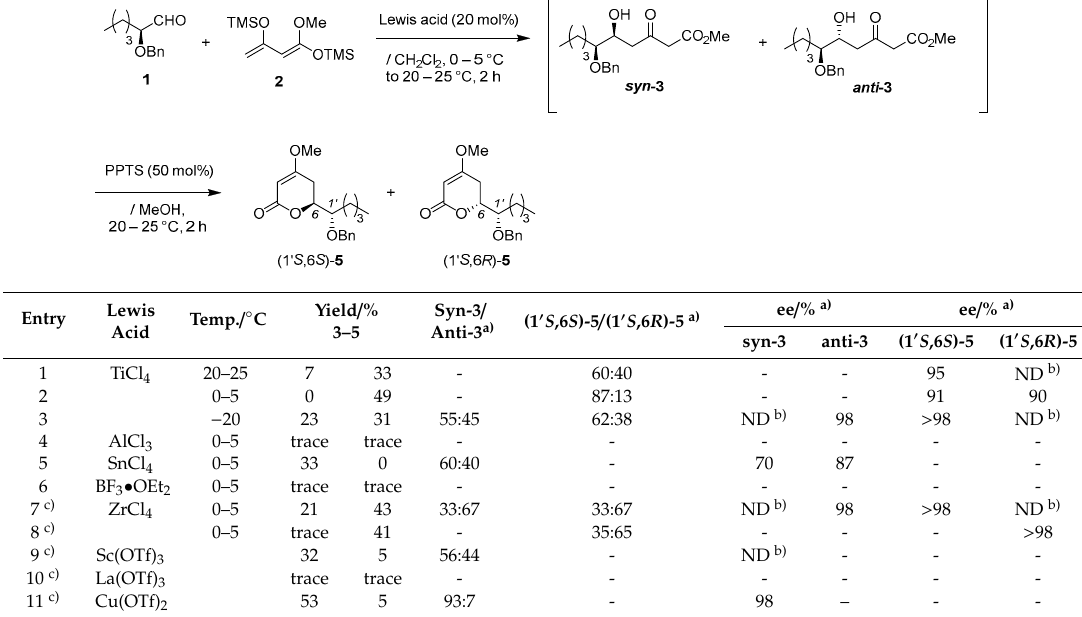
Table 1; i.e., both the yield and stereoselectivities were moderate to low (entries 1–5). (ii) Among metal triflate catalysts M(OTf)n (M = Sc, La, Cu), only Sc(OTf) 3 afforded moderate result (entry 6), and, in contrast to our expectation Cu(OTf) 2 afforded a disappointing result (entry 8). (iii) A